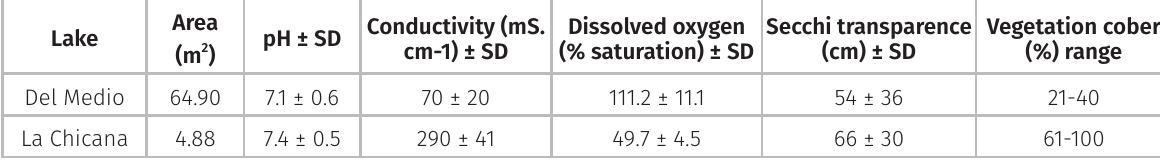
Figure 1. Lentic environments of the Middle Paraná System. a. Del Medio Lake, b. La Chicana Lake (adapted from Devercelli et al. 2016). Table I. Environmental characteristics of the aquatic systems considered (taken from Devercelli et al. 2016), obtained in two lakes of the Middle Paraná System,